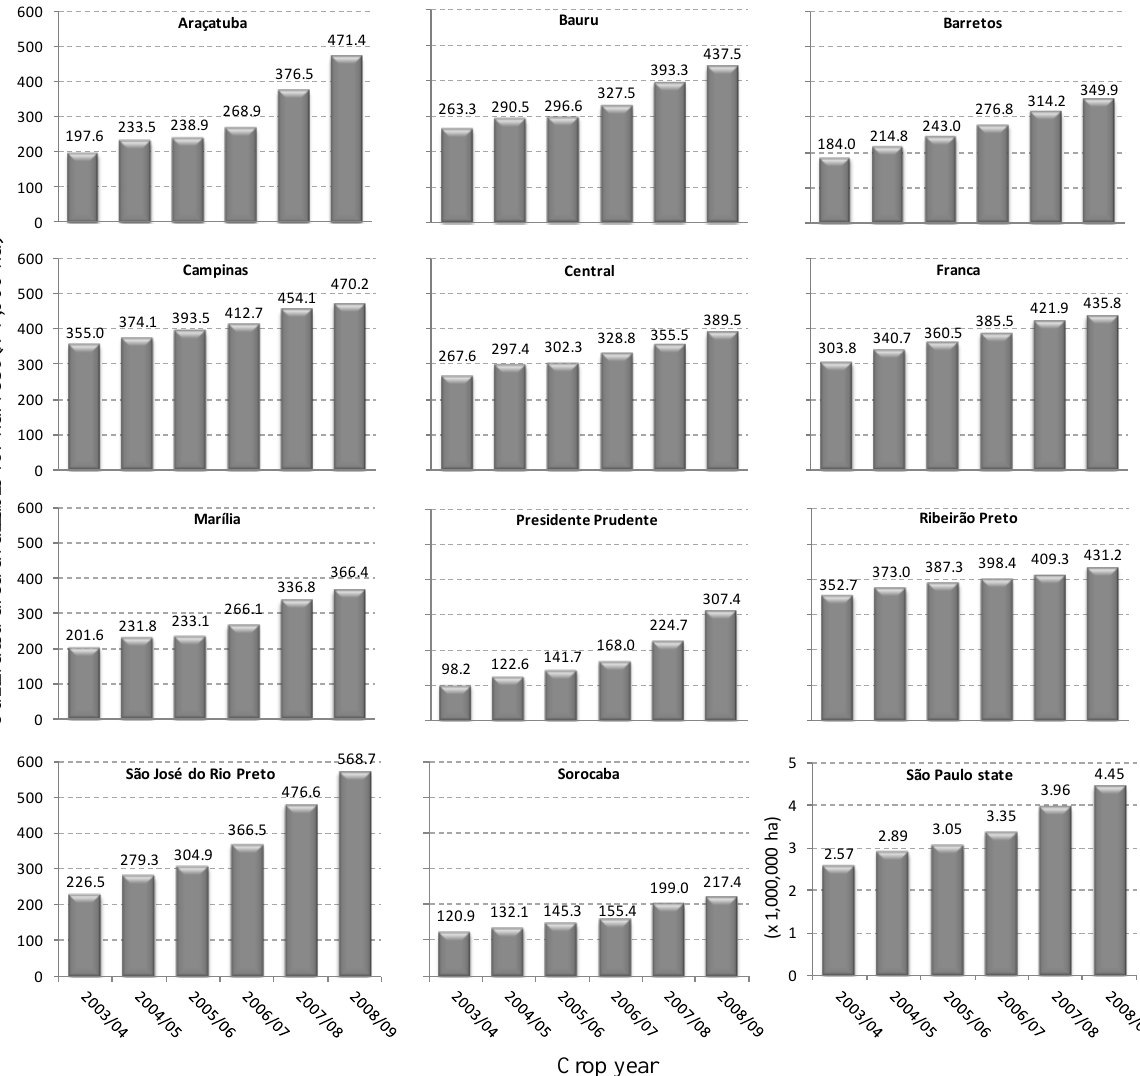
Figure 5. Cultivated sugarcane area available in thousands of ha from crop years 2003/04 to 2008/08 for each Administrative Regions (ADRs) and for São Paulo